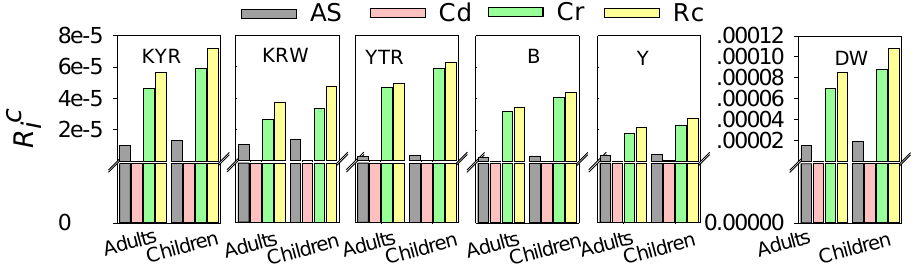
Figure 3. The value of the carcinogenic health risks assessment of the different regions of Bay County. KYR: Keyir, KRW: Kariwak, YTR: Yatur, DW: Dawanqi, Y: Yangchang, B: Bulong.